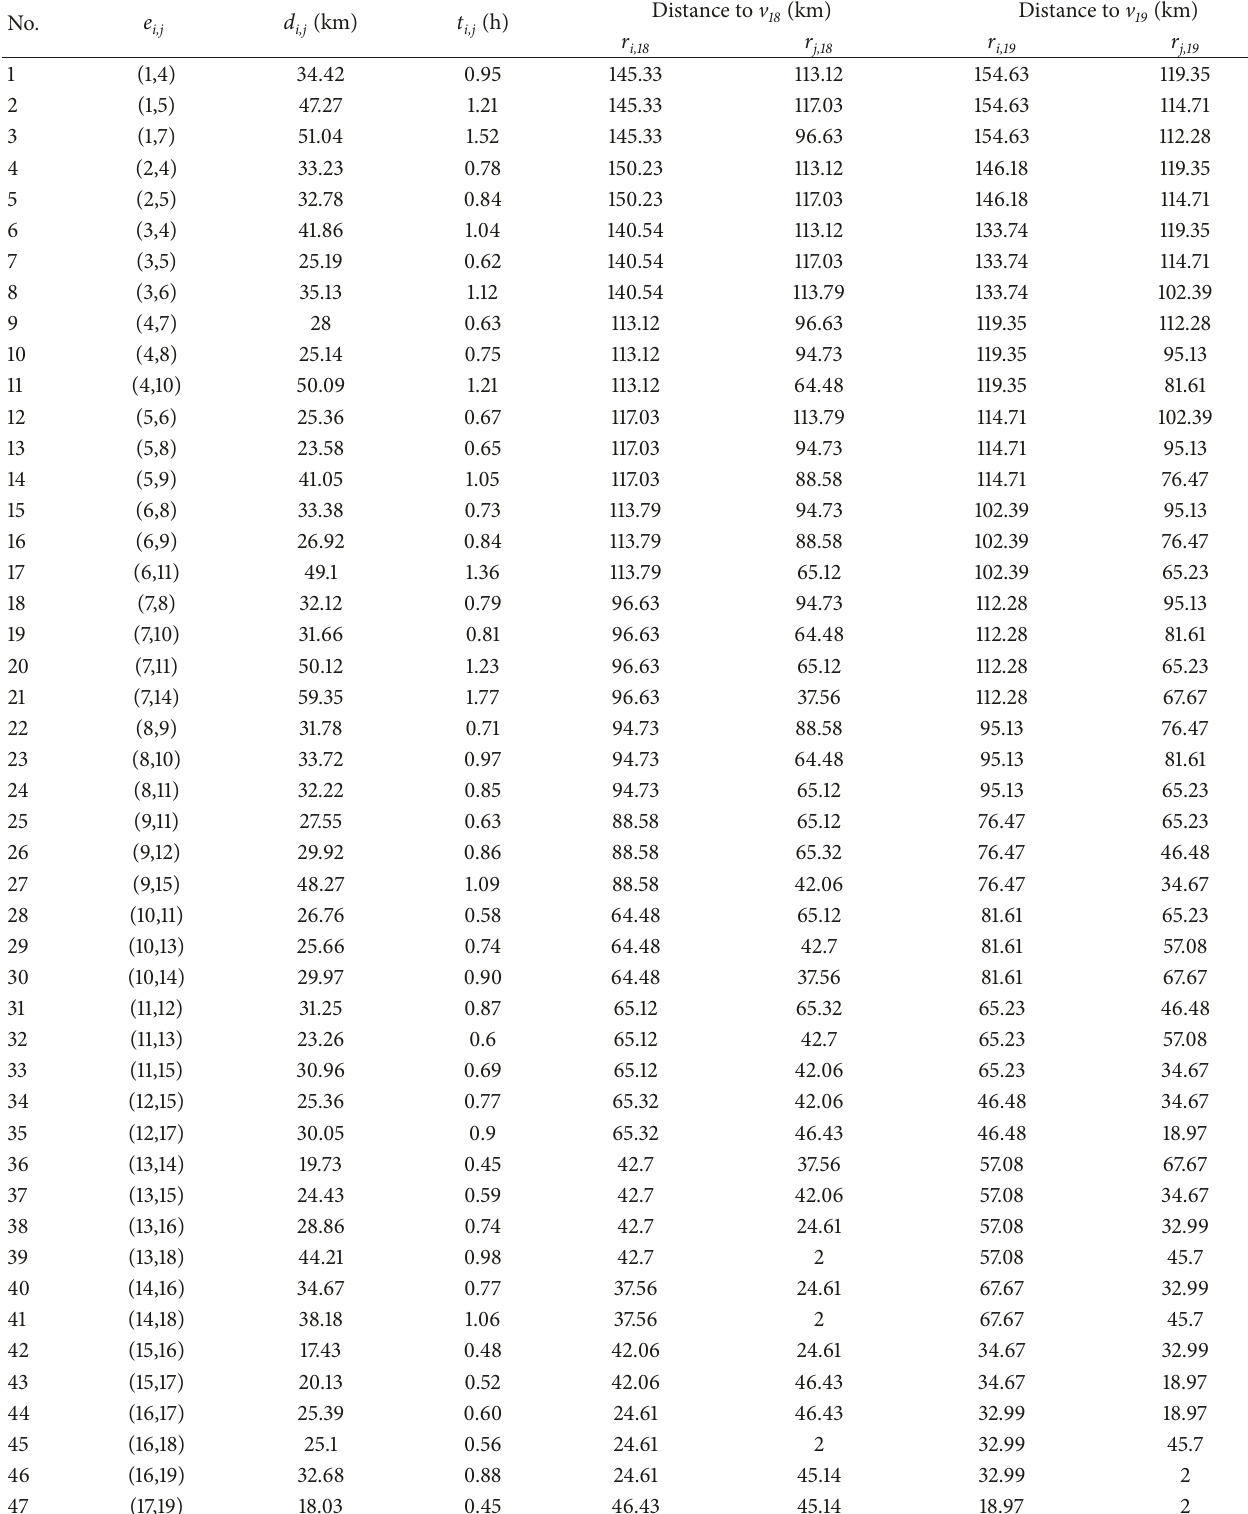
Table 1: Values of related